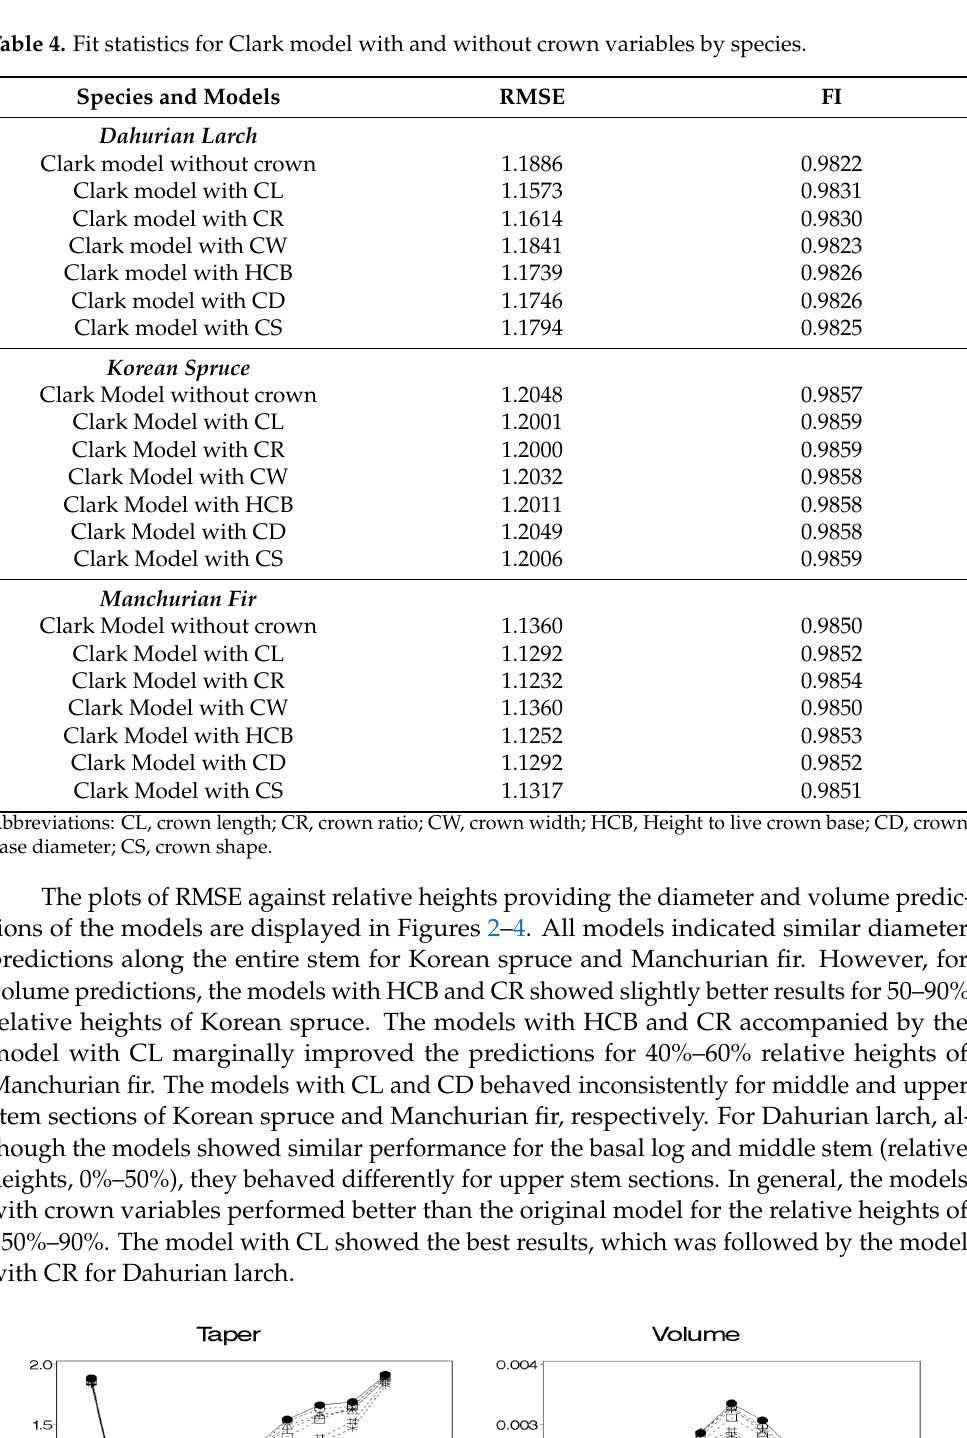
Figure 3. Root mean square error (RMSE) by relative height classes for diameter and volume pre- dictions using Clark model with and without crown variables for Korean spruce. Figure 4. Root mean square error (RMSE) by relative height classes for diameter and volume pre- dictions using Clark model with and without crown variables for Manchurian fir. (For Figures 2–4: Symbols for Clark model with and without variables; Clark (dot), crown length (CL) (star), crown ratio (CR) (hash), crown width (CW) (circle), diameter at crown base (CD) (triangle), height to live crown base (HCB) (square) and crown shape (CS) (plus).